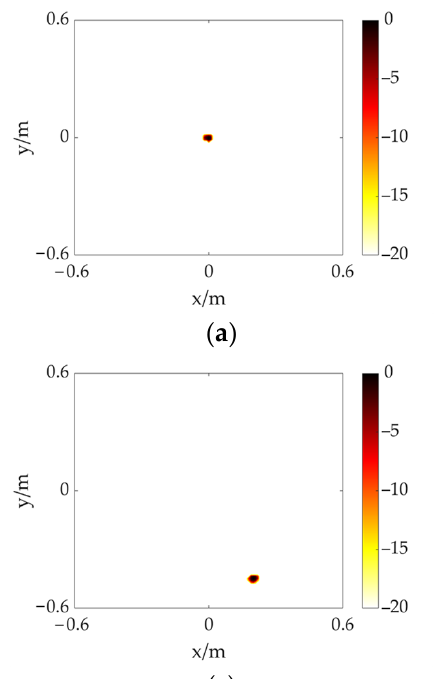
and (0.20, − 0.45). Distance is 3 m. ( a ) FFT-FISTA, (0, 0); ( b ) CSIF, (0, 0); ( c ) FFT-FISTA, (0.20, − 0.45);